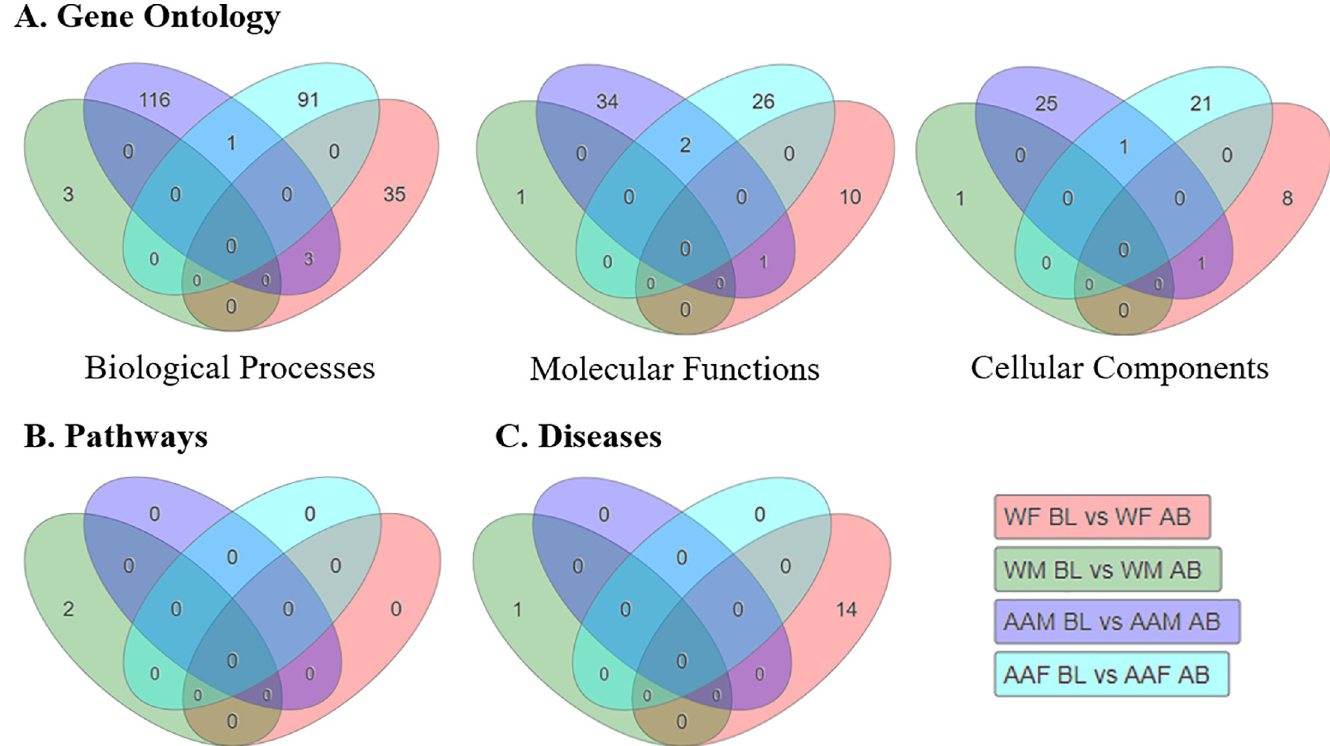
Fig 3. Gene ontology and pathway analysis of top poverty-related genes. Venn diagrams breaking down significant (A) GO terms related to Biological Processes, Molecular Function, or Cellular Components and stratified by poverty status for each comparison. iPathway Guide identification of unique and overlapping genetic pathways (B) or diseases (C) related to observed DGE in each comparison (N = 6/7 per group; see S1 Table for complete demographics). White females below poverty (WFBL) or above poverty (WFAB); white males below poverty (WMBL) or above (WMAB); African American males below poverty (AAMBL) or above (AAMAB); African American females below poverty (AAFBL) or above